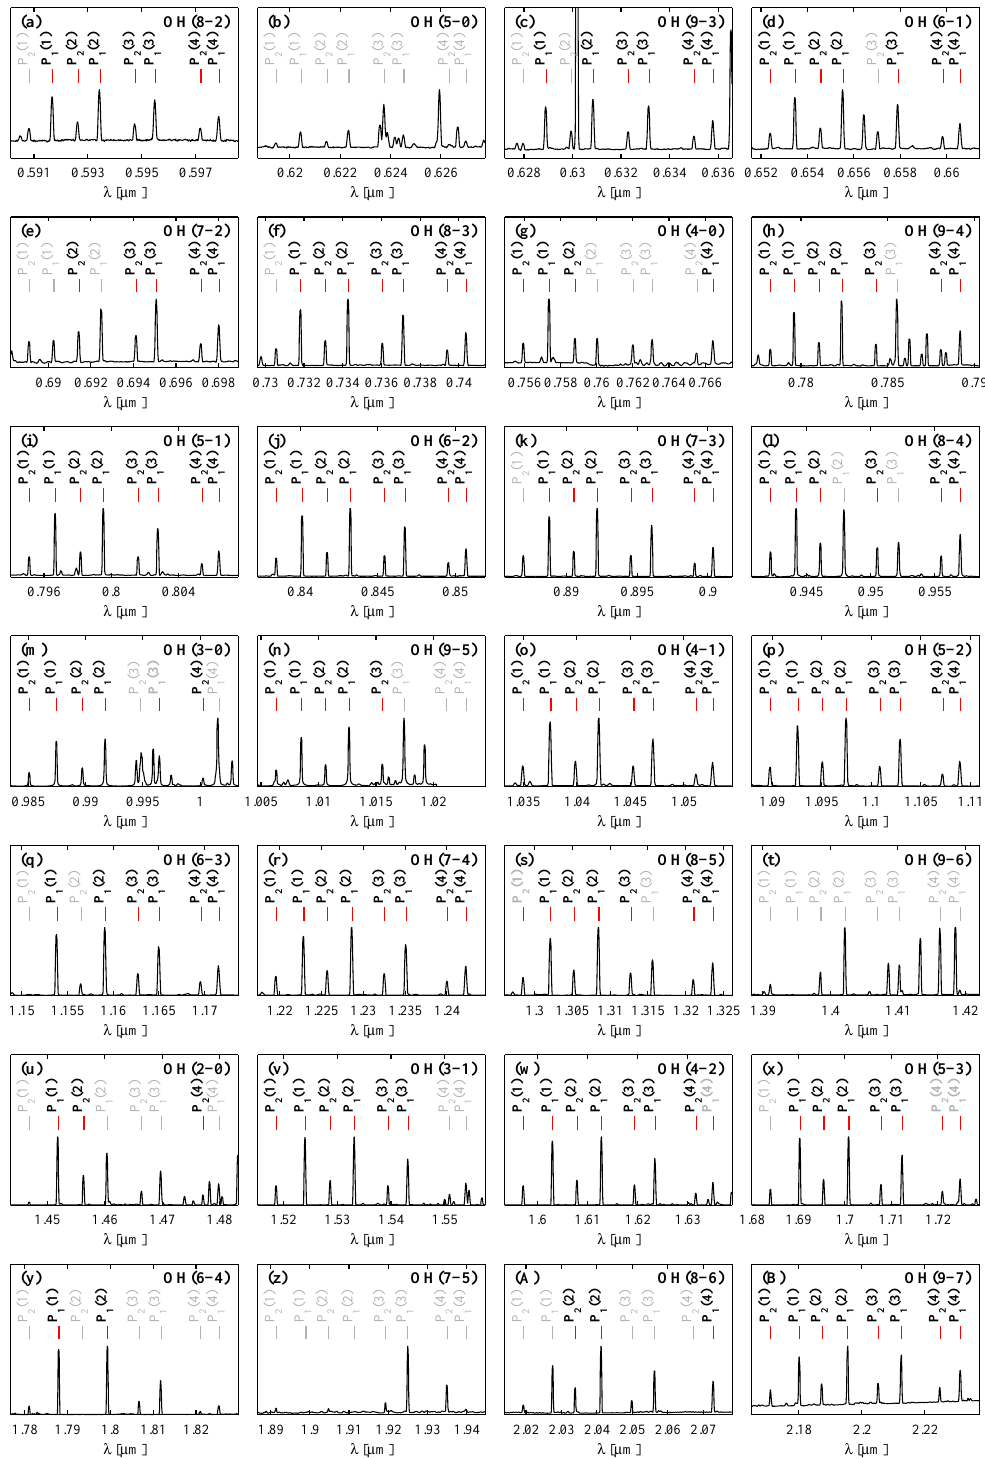
Figure 2. P -branch lines of the OH bands used in this study. The displayed spectrum is the pixel-related median of the 240 X-shooter VIS- and NIR-arm observations which cover all bands and where a reliable flux calibration could be performed in the K band. Lines with black labels were used for the derivation of temperatures. Lines with grey labels were excluded from this study. An exception are those with red marker lines. They were considered for the T rot correction due to differences in the sets of lines available for each